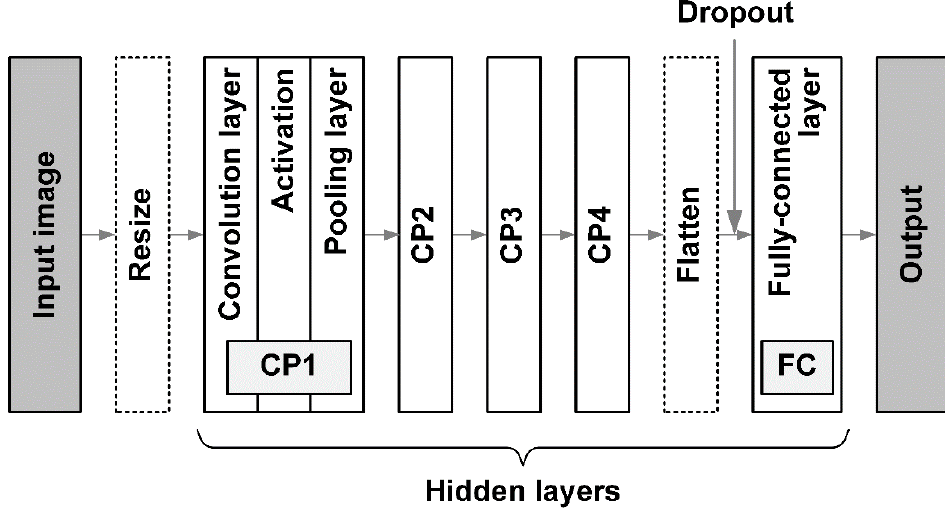
Figure 2. Schematic structure of convolutional neural network used in this study. Each CP layer has a convolution layer, activation function, and pooling layer. The hidden layers consist of CP layers that combine convolution, activation functions, pooling operations, and a fully coupled layer (FC). The convolution layer in a CP layer has multiple channels, and image information is stored in each channel; the current and previous layers are connected by convolution with filters, which are small images. The shapes of the filter images are determined during the network training. The image size is reduced during the convolution process. Padding and stride are applied addition- ally to control the image reduction during the convolution operation. After the convolu- tion operation, the data are connected to an activation function and a pooling operation that further reduces the image. For details on each operation, refer to references [24,25].